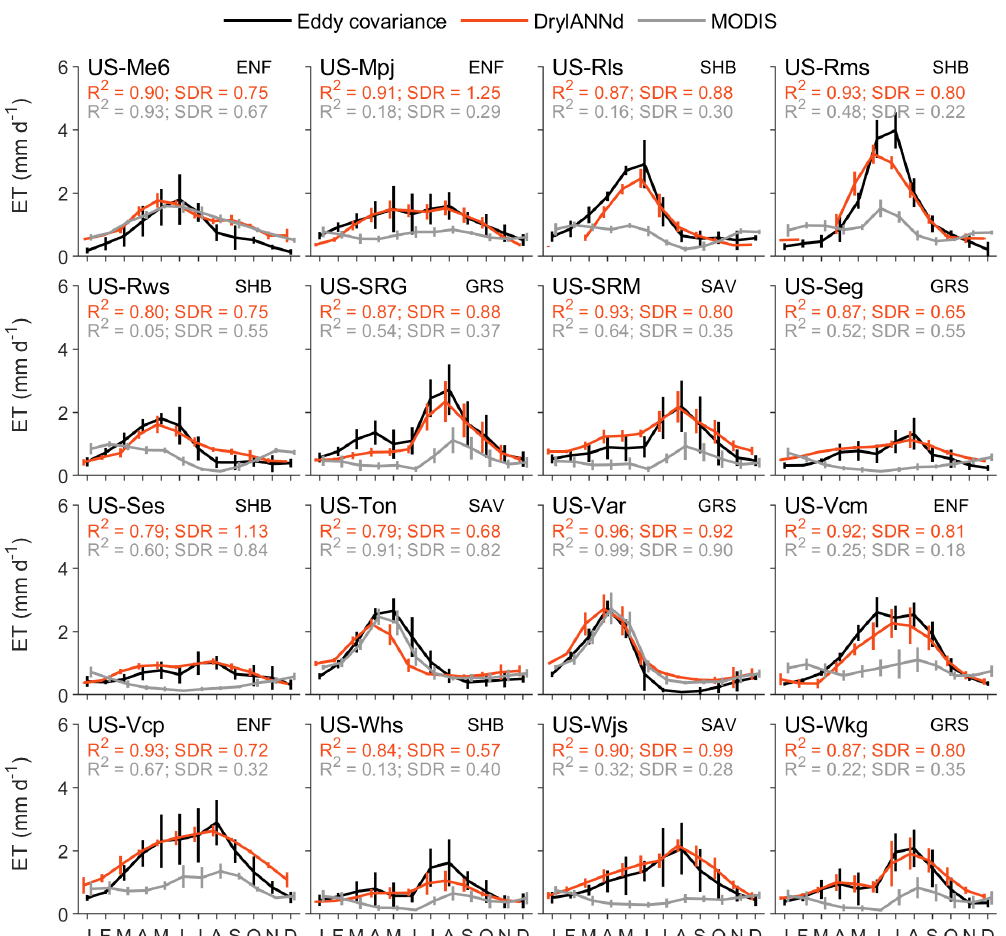
Figure 6. Mean ( ± 1 standard deviation) seasonality of eddy covariance ET (black), DrylANNd ET (red), and MODIS ET (gray) at the 16 sites with complete flux records. Monthly means and standard deviations for all three datasets were estimated using all available observa- tions during the period 2015–2020. Standard deviation ratio (SDR) < 1 indicates that the model underestimated the magnitude of seasonal variability, and SDR > 1 indicates that the model overestimated the magnitude of seasonal